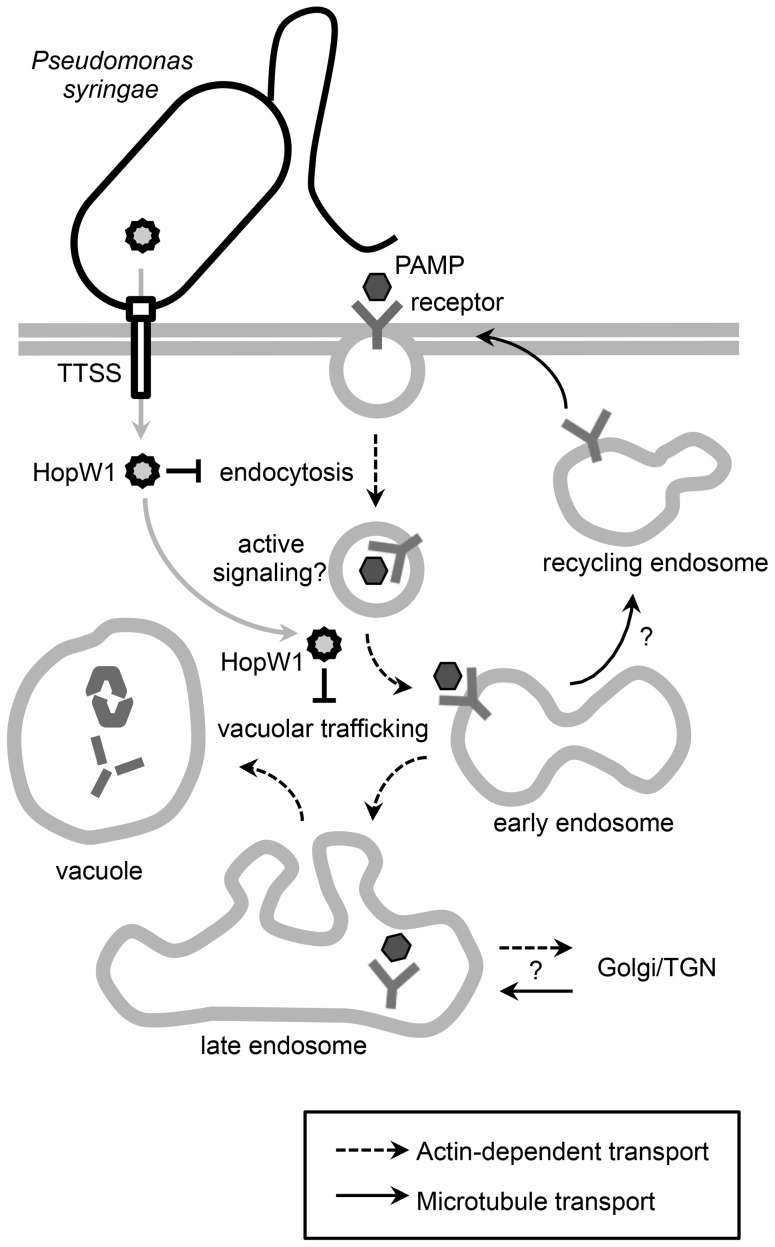
A schematic diagram of HopW1's effects on plant cells.Model showing that the P. syringae effector HopW1, secreted through the type three secretion system (TTSS) disrupts actin-dependent events that may be important for defense. Disruption of actin-dependent endocytosis may reduce active signaling from endosomes. It is also possible that disruption of actin-dependent vacuolar trafficking suppresses defenses by preventing efficient delivery of defense proteins to the vacuole or that some other actin-dependent defense process is disrupted. Proteins and possibly other molecules that are targeted to vacuoles have previously been implicated in various defense-related responses to infection [38], [52].